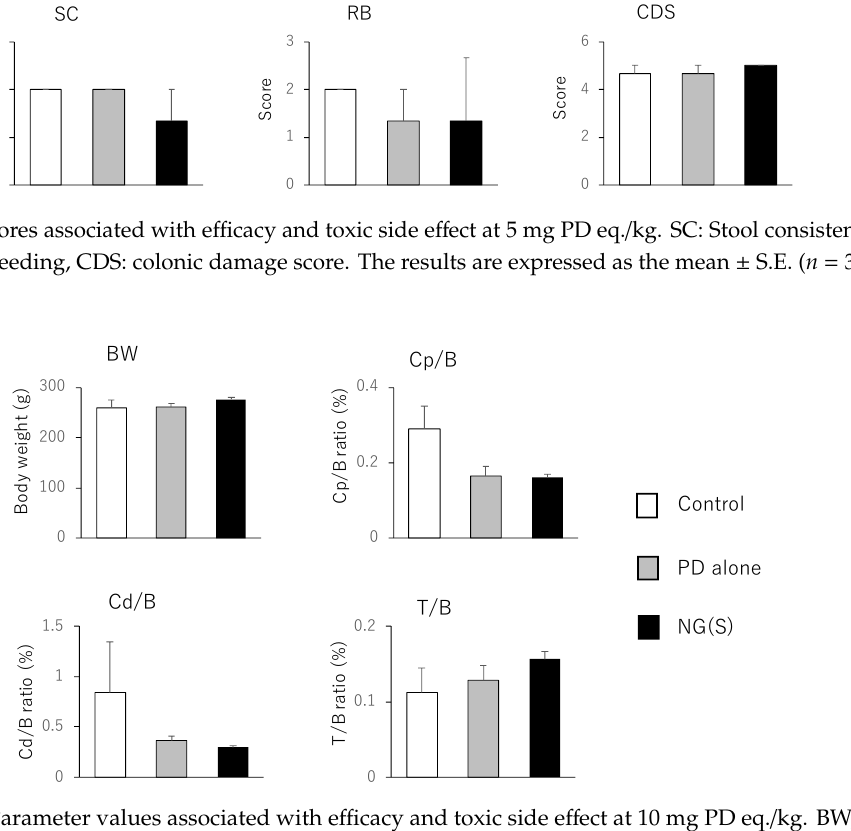
Figure 10. Parameter values associated with efficacy and toxic side effect at 10 mg PD eq./kg. BW, B: body weight, Cp: proximal colon weight, Cd: distal colon weight, T: thymus weight. The results are expressed as the mean ± S.E. ( n = 4).